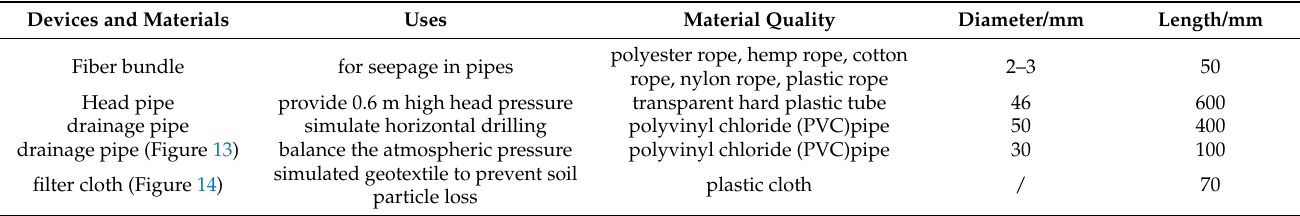
Figure 12. A test diagram of the fiber bundle drainage pipe. Table 4. The material specifications and uses.